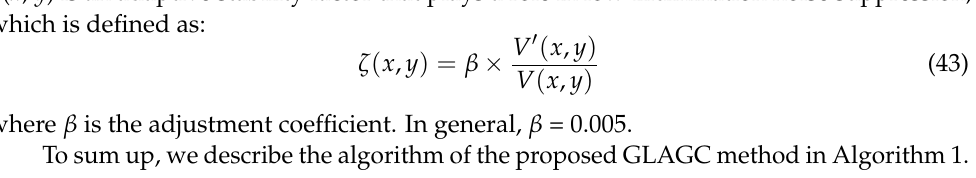
Algorithm 1 Algorithm for the adaptive dual-gamma function for image illumination perception and correction in the wavelet domain (GLAGC) Algorithm’s inputs: Original image S ( x , y ) Algorithm’s output : Enhanced image O ( x , y